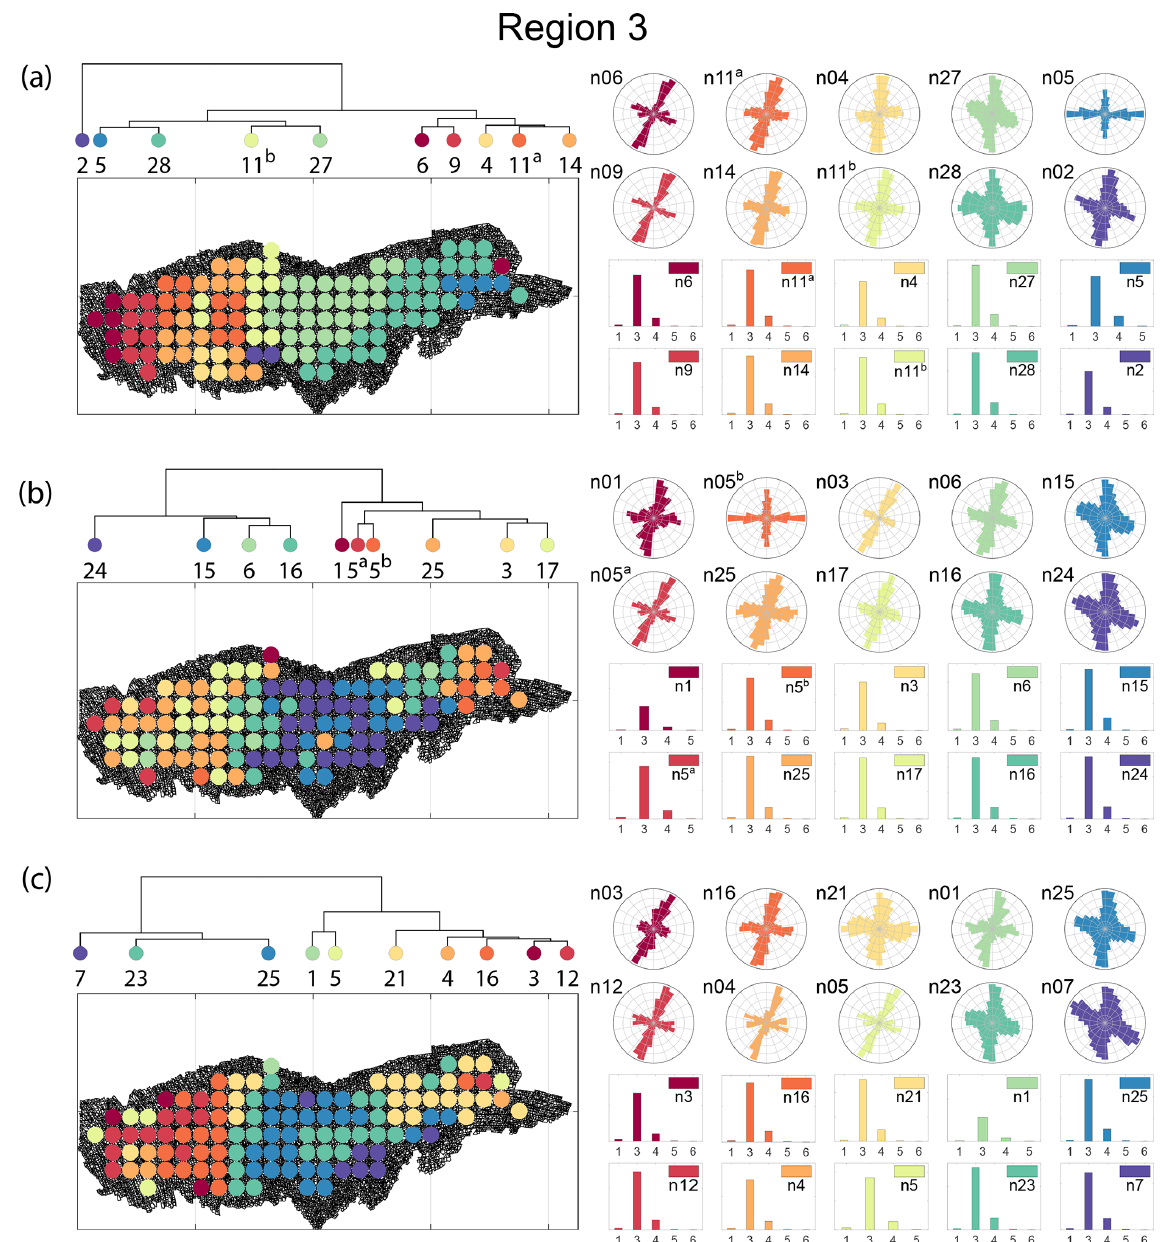
Figure 22. Variation in fracture orientations and topological summary for Region 3 corresponding to (a) fingerprint distance, (b) D-measure, and (c) portrait